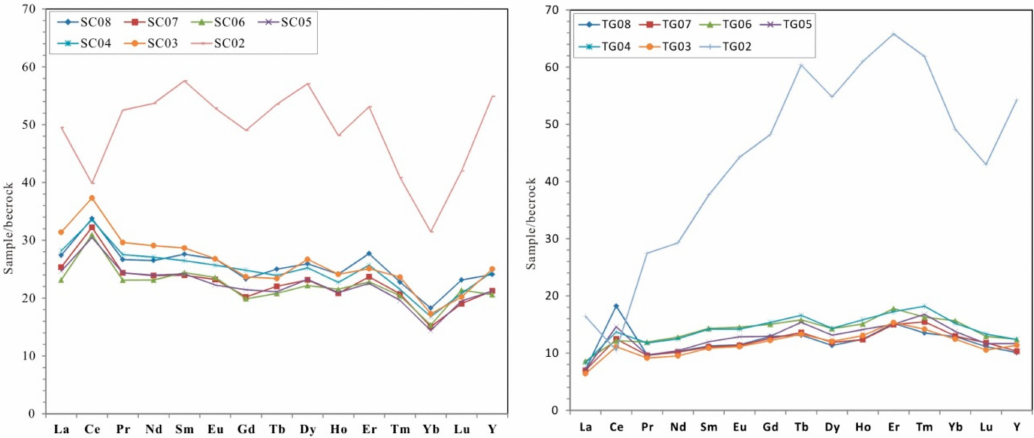
Figure 6. Bedrock-normalized REE distribution patterns for samples from the SC and the TG